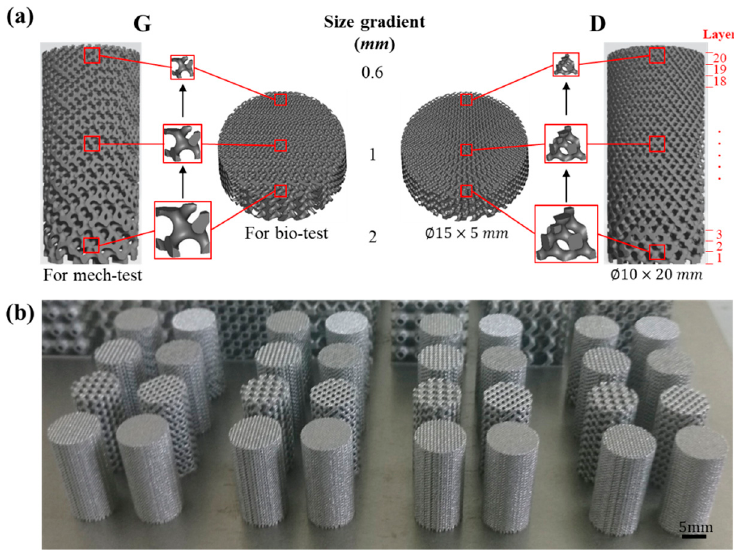
Figure Figure 1. ( a ) Designed models of cell-size gradient samples and ( b ) as-built samples for compressive tests.